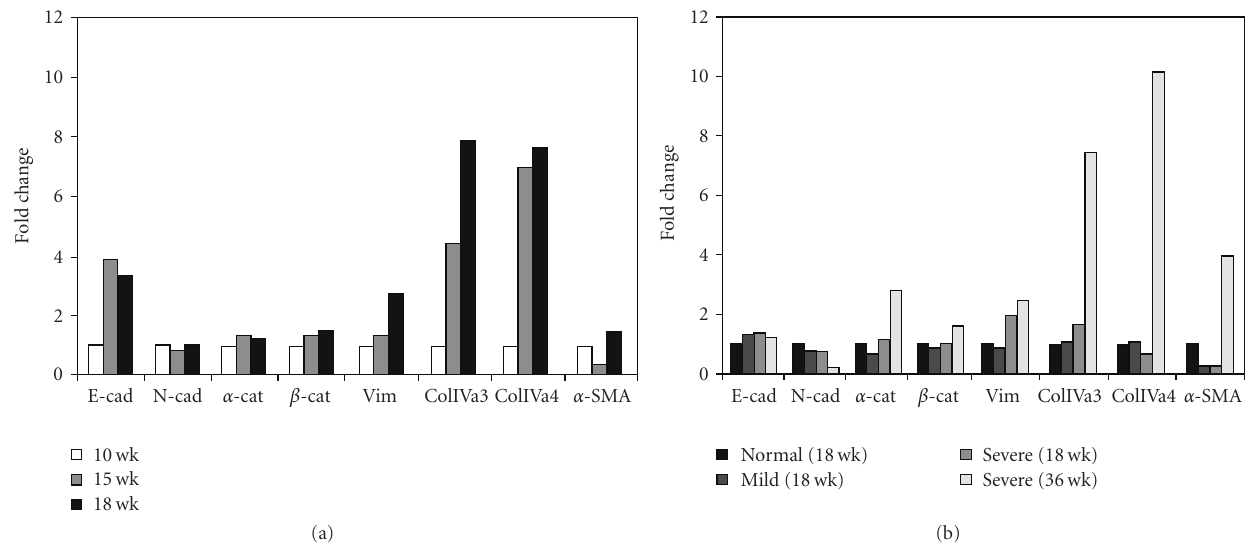
Figure 7: Gene expression in normal and obstructed fetal kidneys . (a) Quantitative PCR analysis of total RNA extracted from 10, 15, and 18 weeks gestation normal kidneys, for genes encoding epithelial-specific (E-cad, N-cad, α -cat, and β -cat) and mesenchymal-specific (vimentin, ColIVa3, ColIVa5 and α -SMA) proteins. Values are expressed as fold change in mRNA expression compared to the normal 10 weeks gestation kidney as reference. (b) Quantitative PCR analysis of total RNA extracted from obstructed kidneys at 18 weeks gestation (mild and severe) and 36 weeks gestation (severe), and from 18 weeks normal kidney. Values are expressed as fold change in mRNA expression compared to the normal 18 weeks gestation kidney as